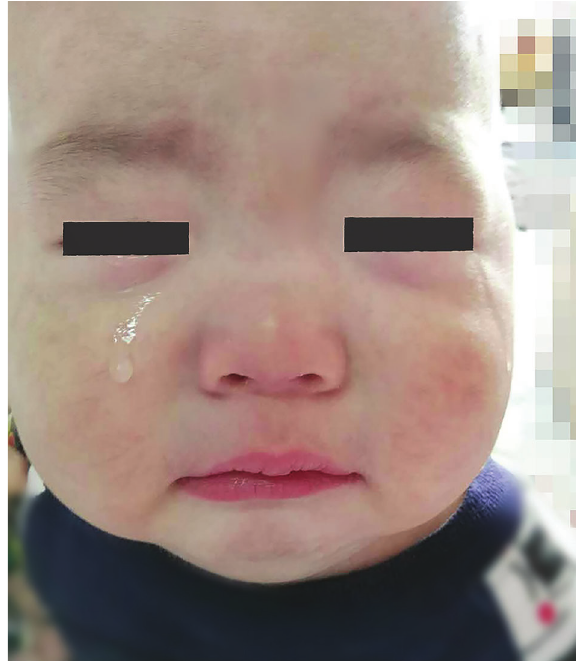
Figure 1. Oculocutaneous albinism and patchy hypopigmenta- tion of the skin of a 9-month old boy with Chediak-Higashi syndrome.